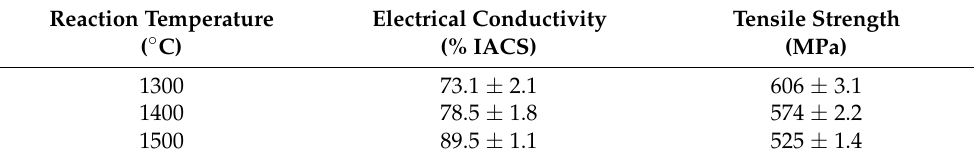
Figure 4. Stress–strain curves of deformed (TiB 2p +TiB w )/Cu composites at different reaction temper- atures. Table 1. The properties of (TiB 2p +TiB w )/Cu composites at different reaction temperatures.